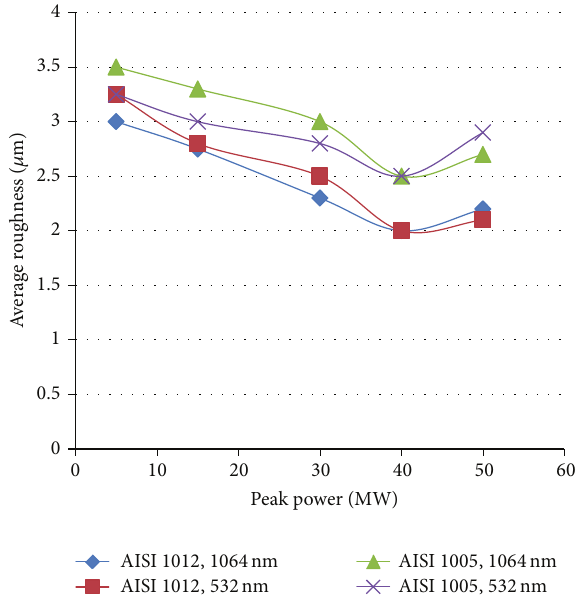
Figure 3: SEM image 1000x at 𝑃 𝑝 40MW and PRR 4Hz.